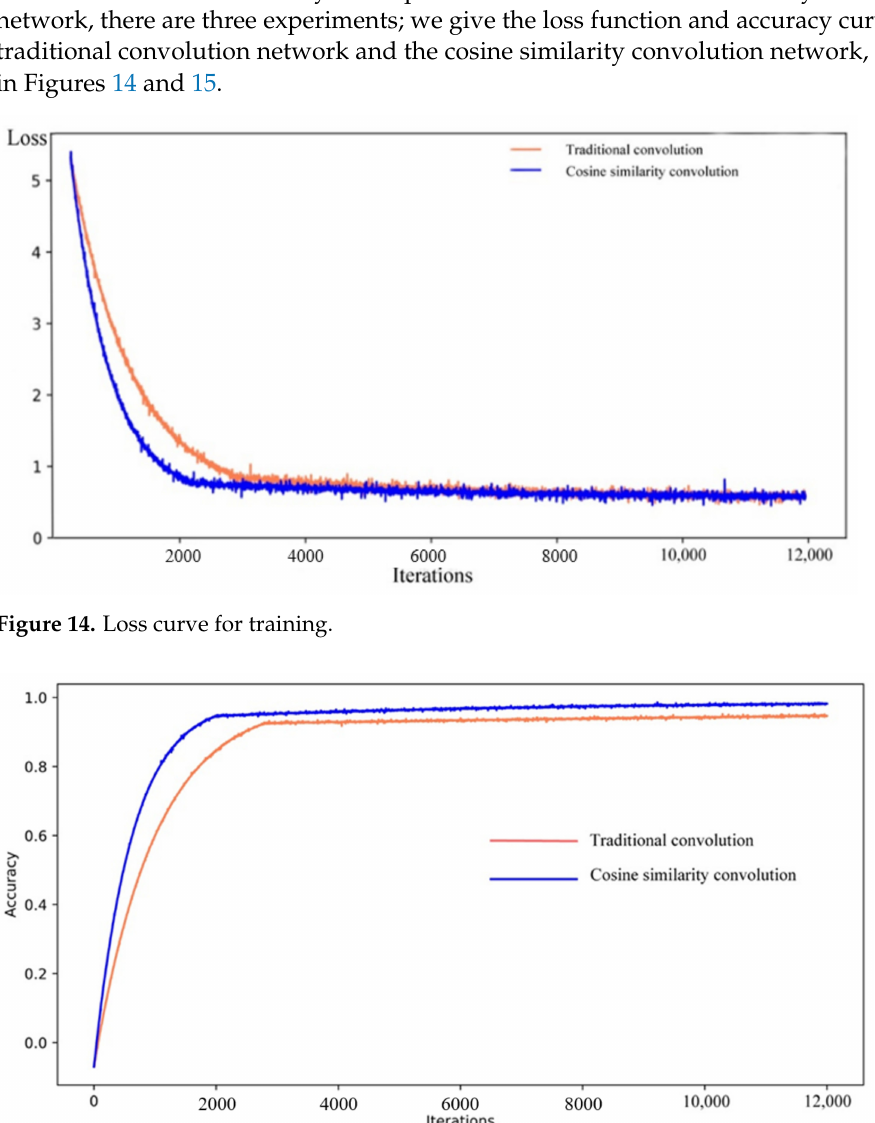
Figure 15. Accuracy curve for